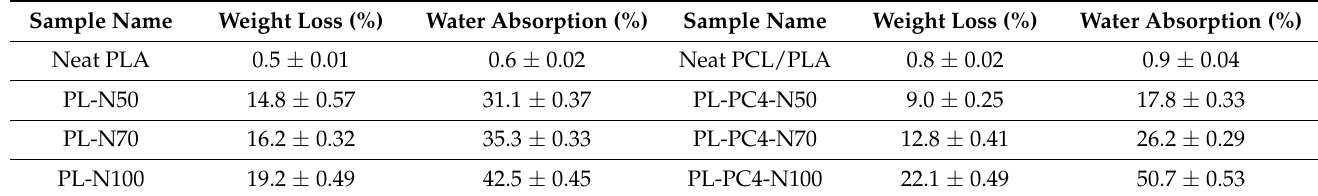
Table 7. Water absorption and weight loss of neat and porous PLA and PCL/PLA